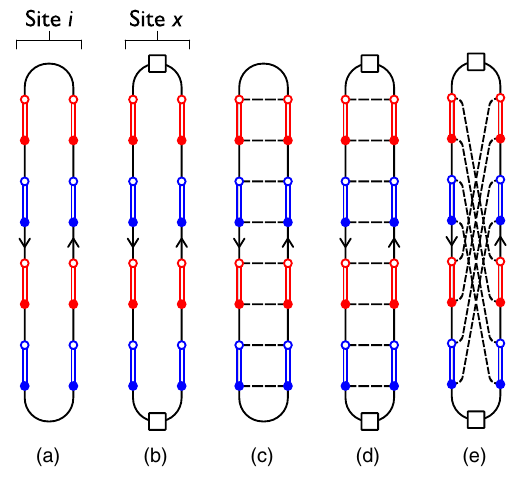
FIG. 8. (a),(b) Site diagrams associated with ½ O ð x;t ¼ 2 Þ O ð x Þ(cid:2) av at sites i ≠ x and sites i ¼ x , respectively. Color coding is as in Fig. 7. (c) The leading contraction of the site diagram for x ≠ i . (d),(e) Two alternative contractions of the site diagram for ½ O ð x; t ¼ 2 Þ O ð x Þ(cid:2) at site x . (d) gives a contribution av ∝ Tr O 0 . (e) has A ð G ≠ 0 but forces similar con- A ð G x Þ x ¼ x Þ tractions on adjacent sites via the bond constraint, and these contributions vanish as q → ∞